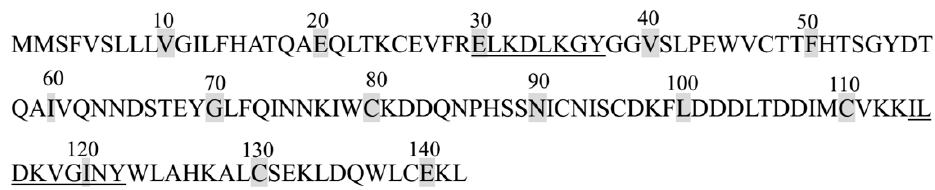
Figure 5. Mature amino acid sequences of bovine α -lactalbumin. Peptide sequences identified in the bovine α -lactalbumin fractions are underlined.